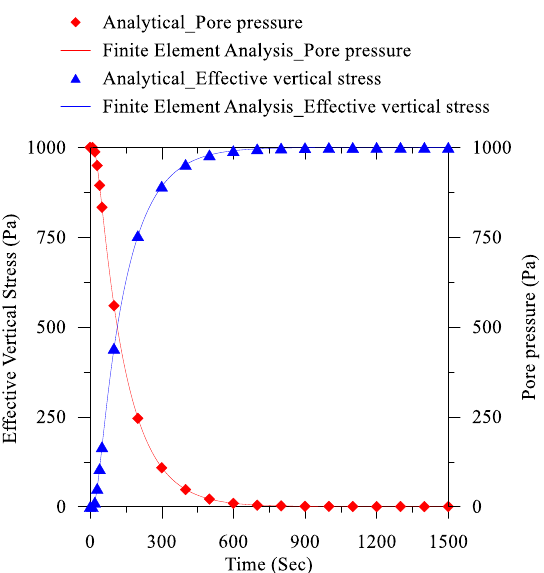
Figure 4. Comparison between the Terzaghi’s 1D consolidation analytical solution and finite element results at the bottom.